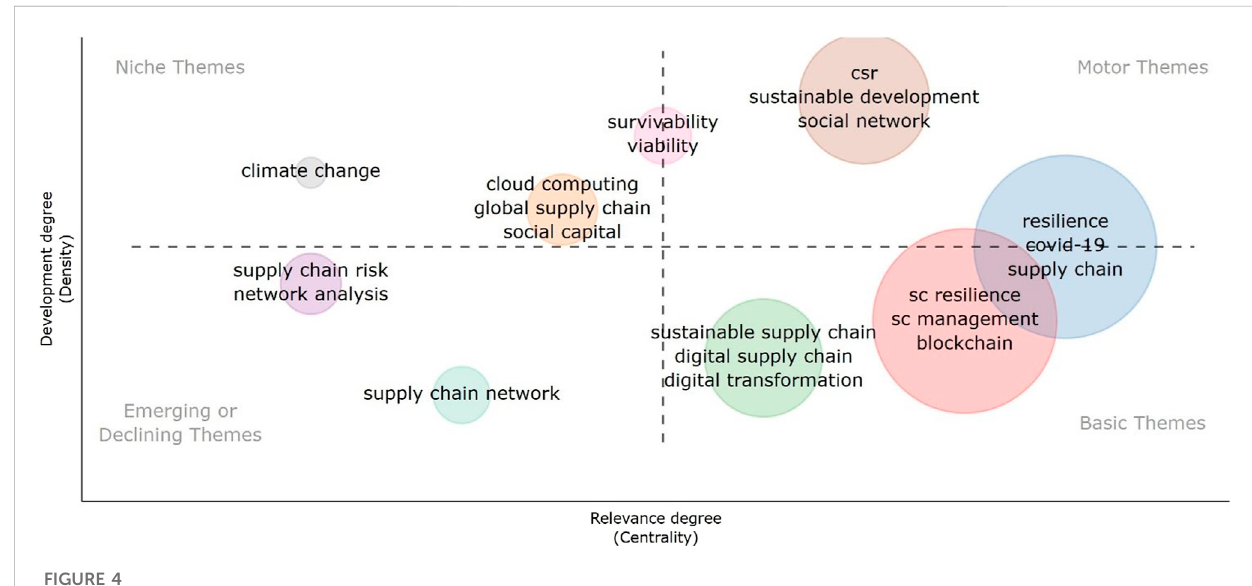
FIGURE 4 Conceptual structure using thematic mapping